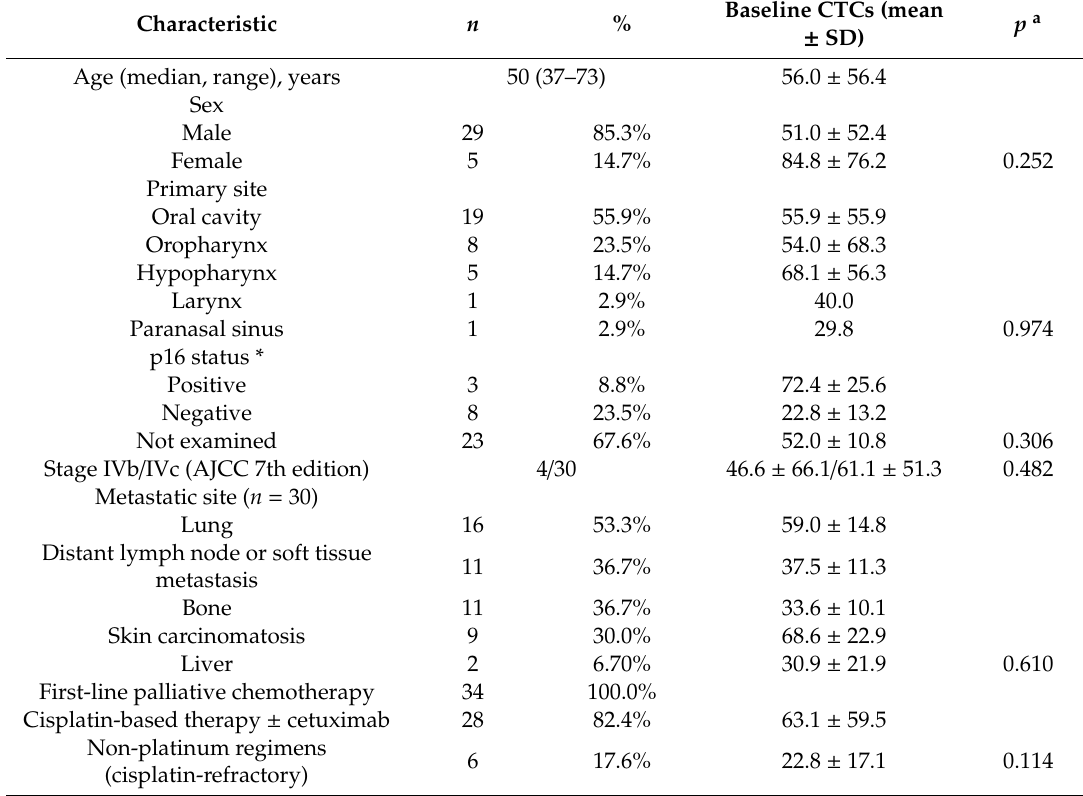
Table 1. The patients’